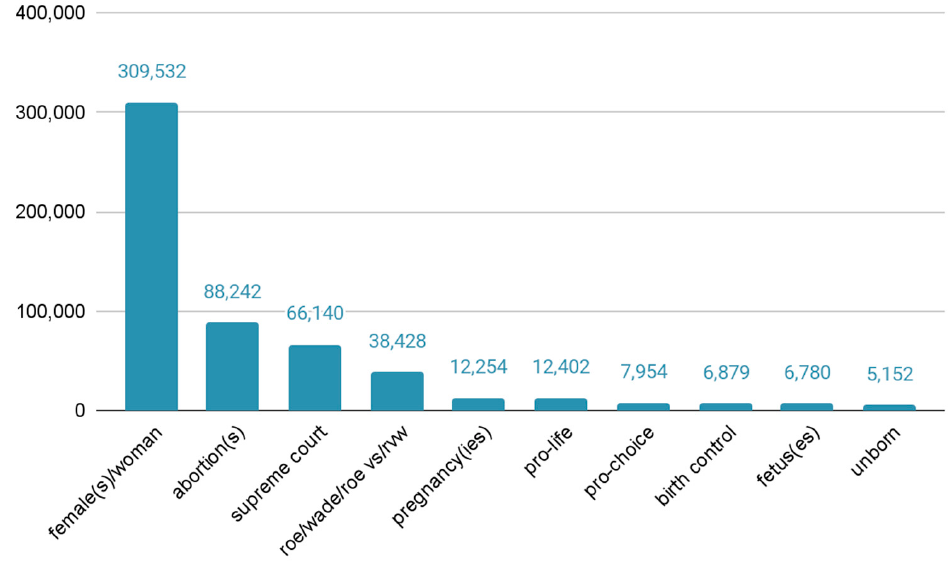
Figure 1. Top terms by frequency of tweet mentions, 1 May–15 July 2022 .